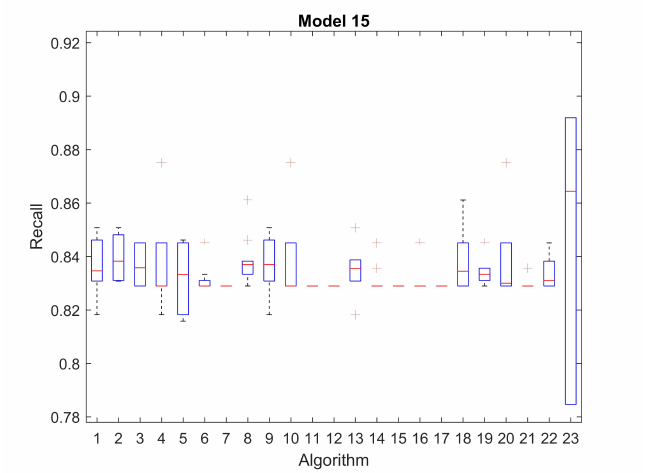
Figure A12. Recall of Model 15 for the different algorithms. The 23 algorithms are represented in the x -axis, and the accuracy is shown in the y -axis.